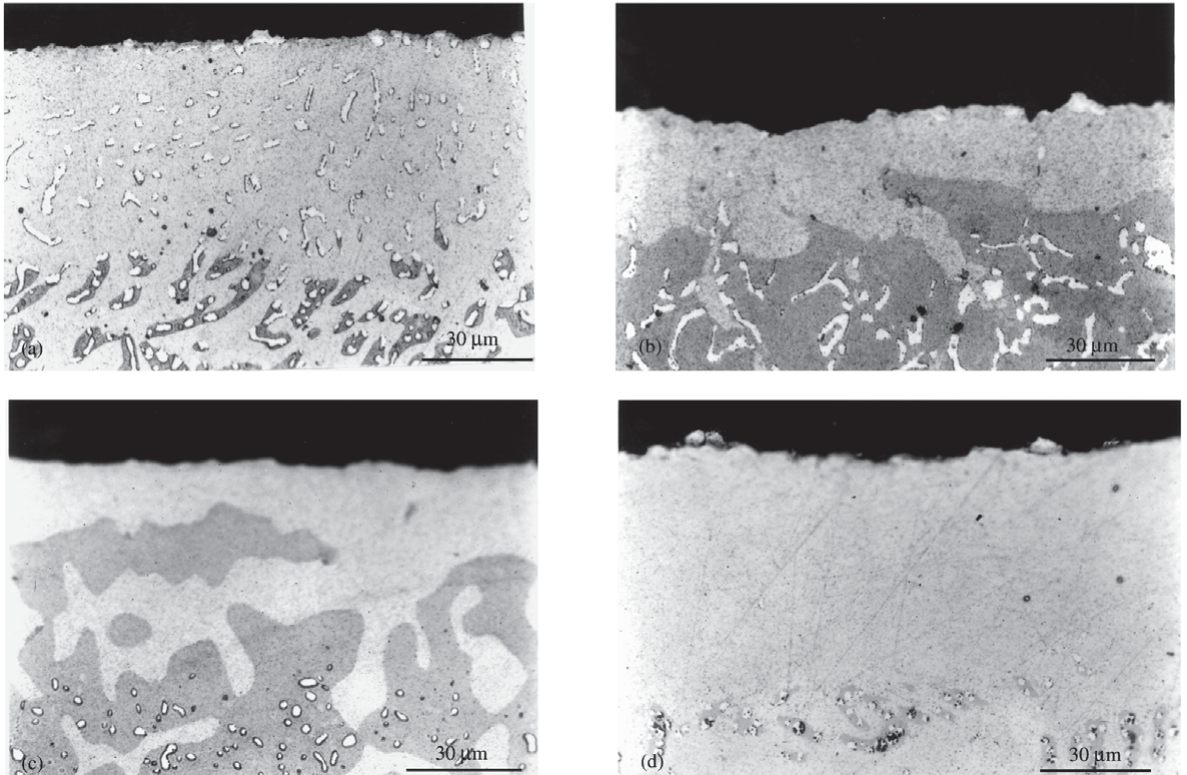
Figure 3. Cross-sections of alloys oxidised isothermally for 260 h: a) Alloy 2; b) Alloy 3; c) Alloy 5; d) Alloy